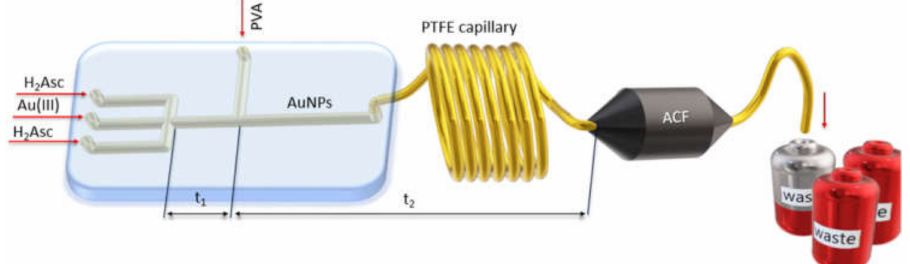
Figure 1. Scheme presented system for continuous particles synthesis and their deposition on the activated carbon surface, where t 1 —time for reduction (Au(III) to Au(I) ions); t 2 —time for nucleation and autocatalytic